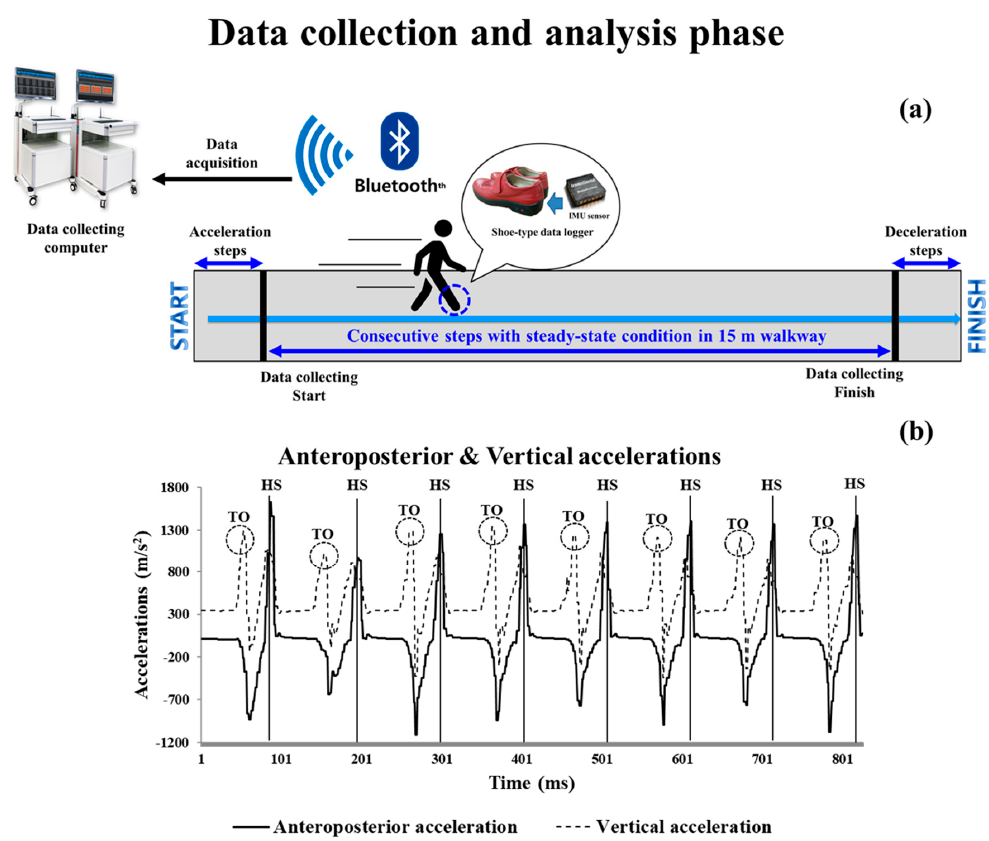
Figure 2. Schematic of the data collection and analysis phase under steady-state conditions. ( a ) Data collection and analysis phase; the blue arrows indicate acceleration to steady-state and deceleration steps after measurements are completed. ( b ) Detection of gait events with the shoe-type inertial measurement unit (IMU) system. Data is collected at 100 Hz. HS, heel strike; TO, toe-off.